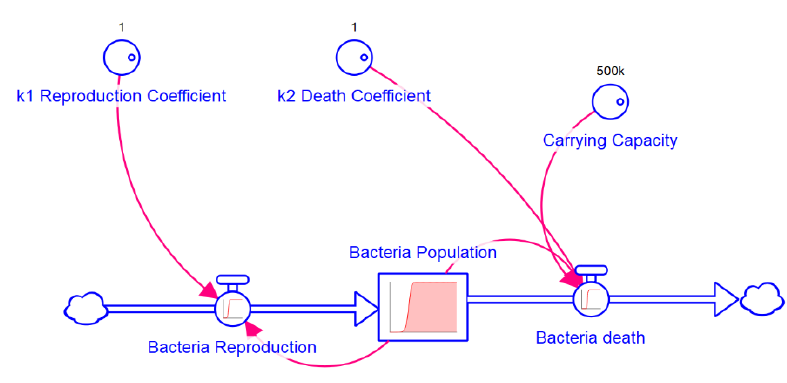
Fig. 24. Bacteria growth stock-and-flow